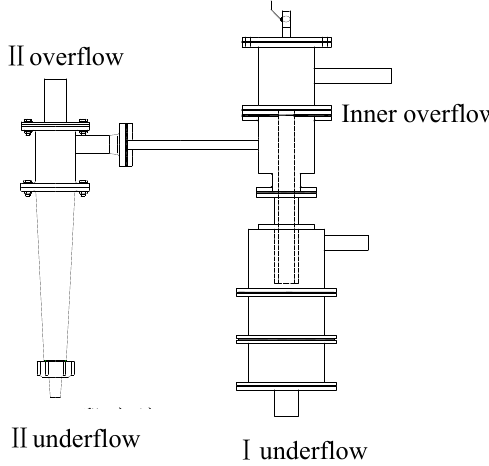
Figure 6. Structural representation of four product cyclone.